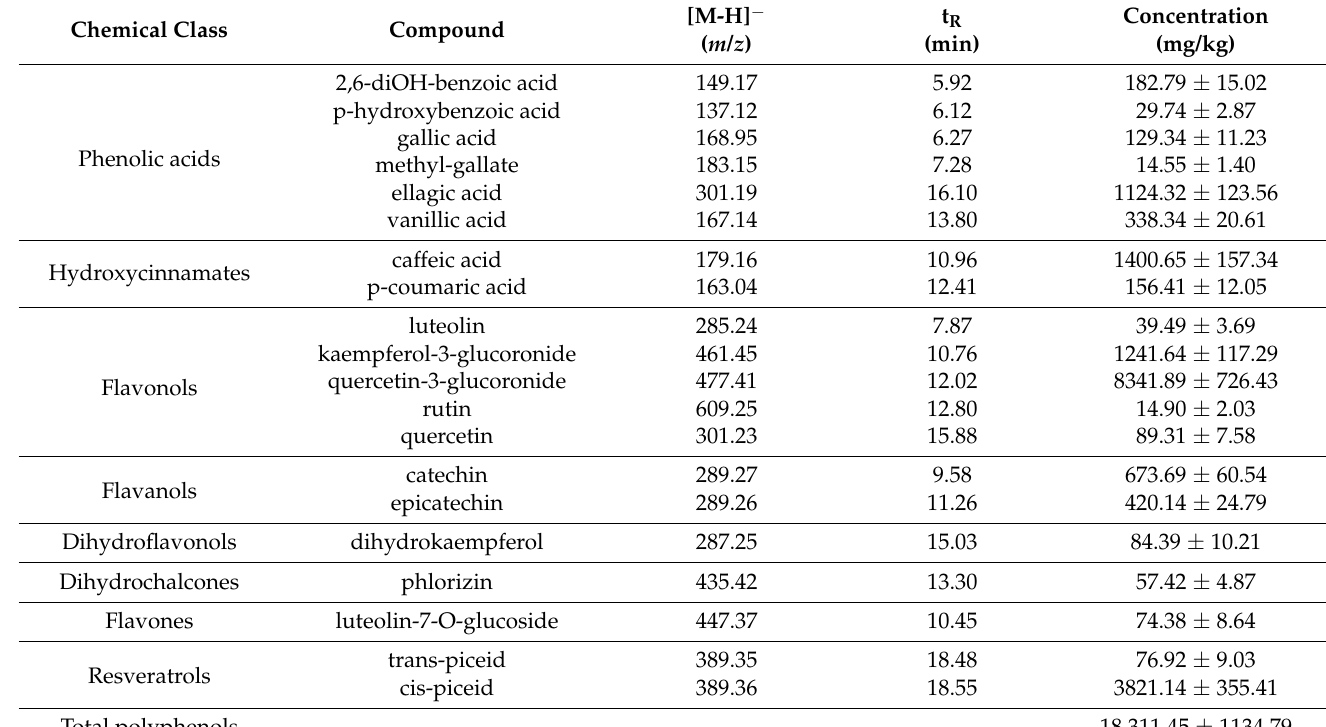
Table 2. Polyphenolic profile of RGJe revealed by RP-UHPLC-MS analysis. Results are expressed as mg/kg of dried extract and are reported as mean ± standard deviation of triplicate measurements. For each compound, the observed deprotonated molecular ion [M-H] − and the retention time (t R ) are also listed.